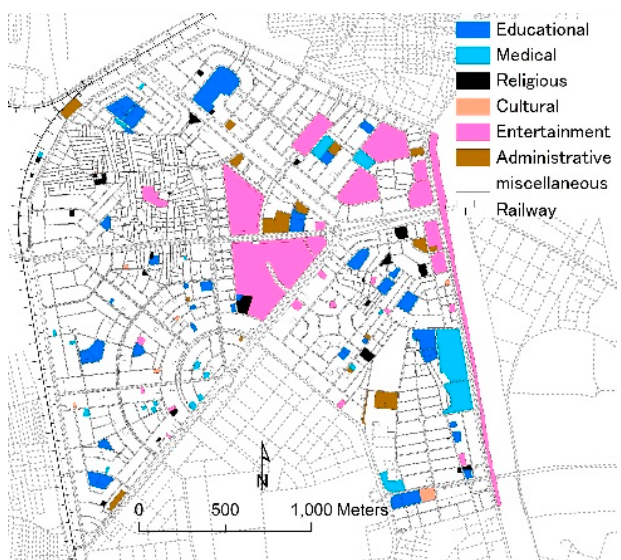
Figure 8. Services in Agouza.